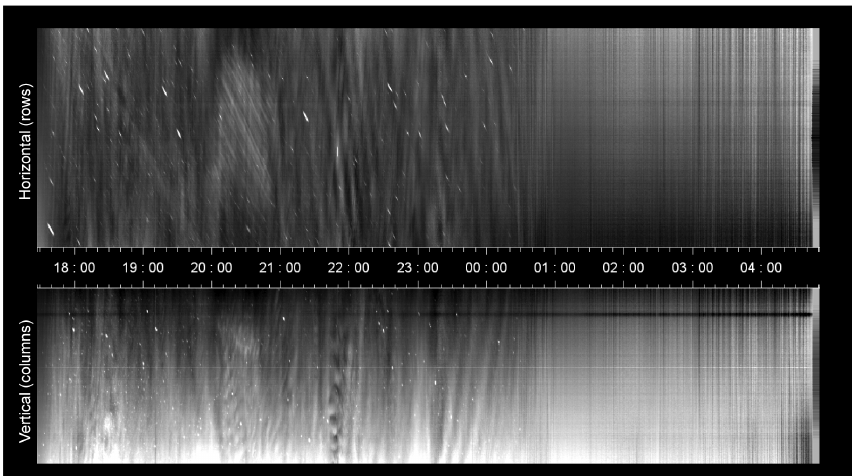
Figure 5. Keogram for one row and one column of images for the night of 3 to 4 October 2014. Between 17:30 and 00:40UTC stars can be seen clearly, but after 00:40UTC dense cloud cover appears. Several wave events can easily be identified at 18:30, 20:00–21:00, 22:00 and 23:30–00:30UTC. The time interval between 21:05 and 22:30UTC is further investigated in Sects. 3 and